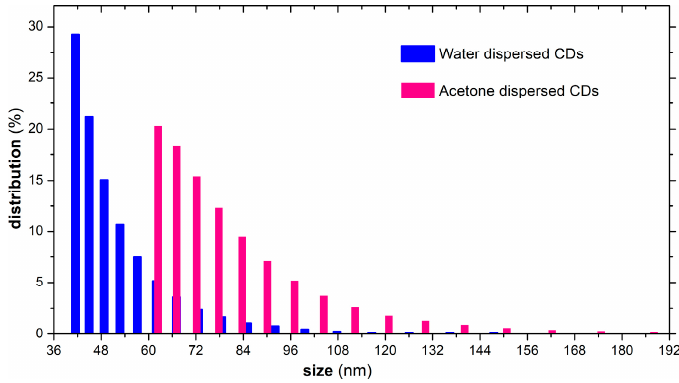
Figure 6. Dimensional distribution recorded for water and acetone dispersed CDs.